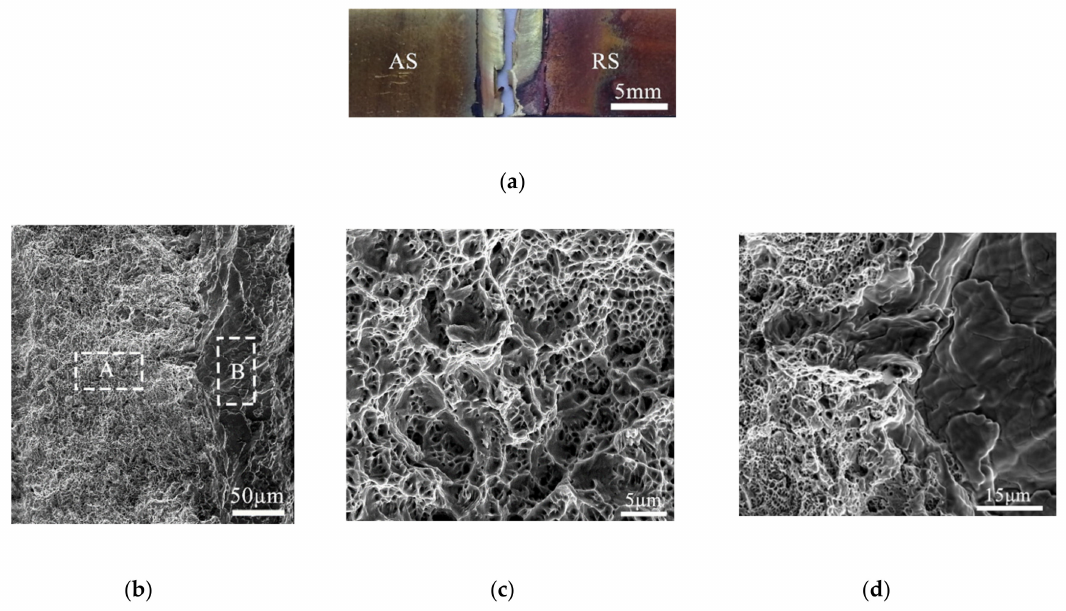
Figure7. Macroandmicrofracturesurfacemorphologiesofjoints(12,000rpm, 280mm / min): ( a )Fracture modes of the joint; ( b ) Fracture surface morphologies of the joints ( c ) Region A presented at high magnification; ( d ) Region B presented at high